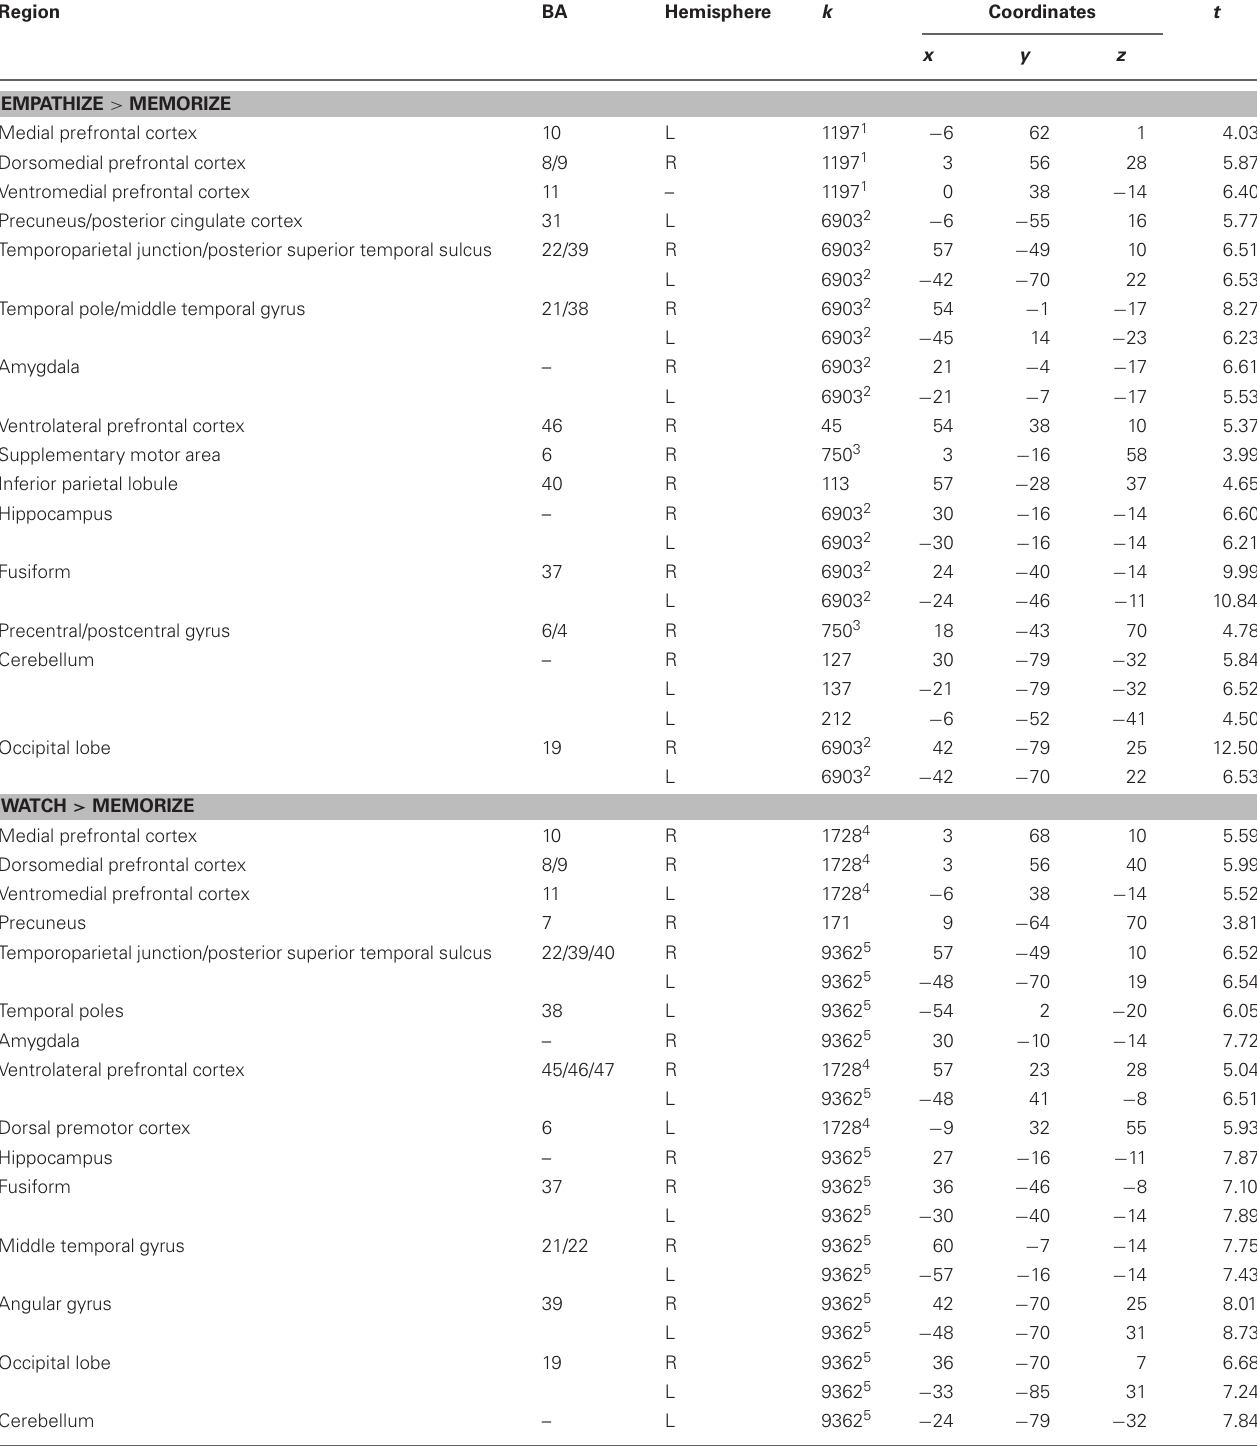
Table 5 | Neural regions that were less active under cognitive load compared to empathize (collapsed across emotions) and less active under cognitive load compared to watch (collapsed across